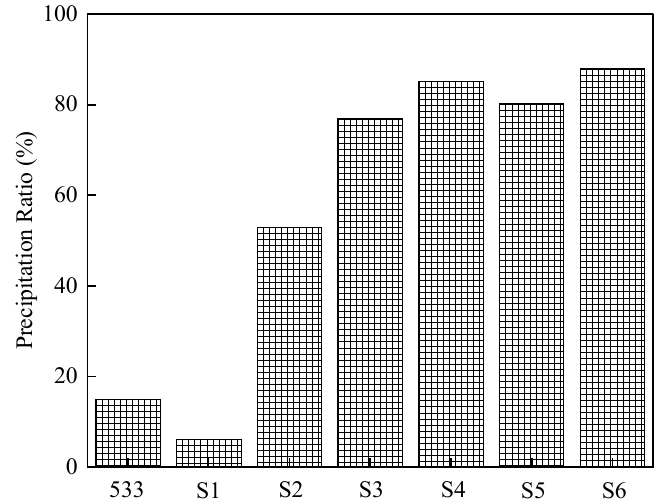
Table 1. Experimental steps.